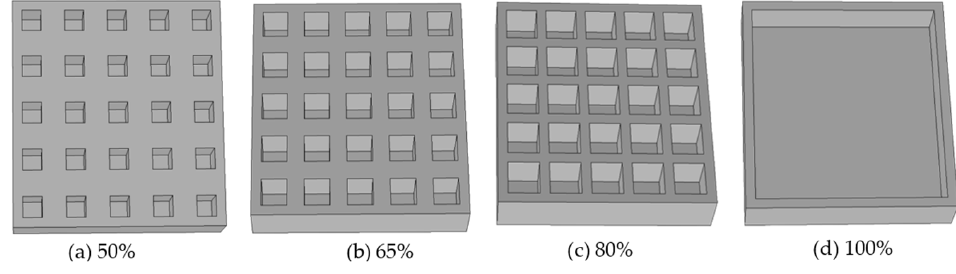
Figure 3. The diagram of different filling ratio.